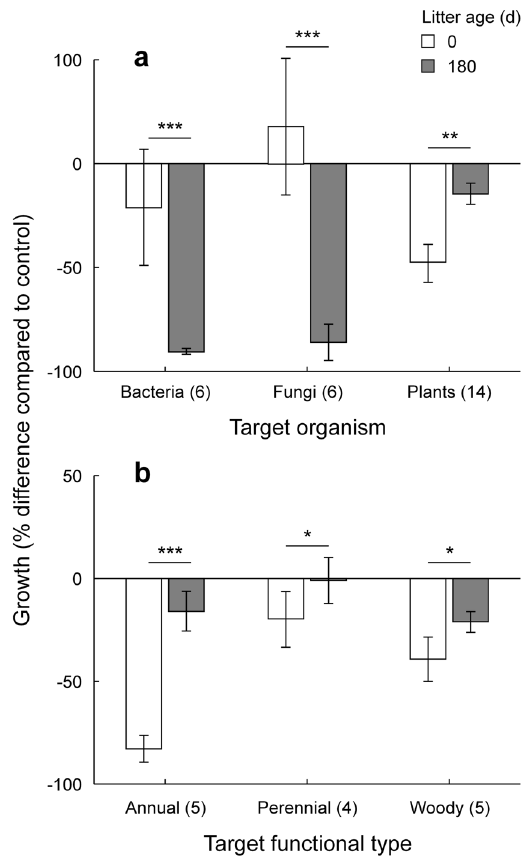
Figure 2. Growth response of different target organisms ( a ) and plant functional types ( b ) to either undecomposed (0 d) or decomposing (180 d) litter. Growth is expressed as percent difference compared to the controls (Nutrient Broth, PDA, and water for bacteria, fungi, and plants, respectively). For each bar, data refer to mean ± standard deviation of different target species (N in brackets) over18 litter types. Asterisks indicate within-group statistically significant differences ( *** p < 0.001; ** p < 0.01; * p < 0.05), according to Tuckey’s HSD post-hoc tests for the interactive effects of litter age and target organisms ( a ) and litter age and plant functional type ( b ) from corresponding GLMMs models in Table